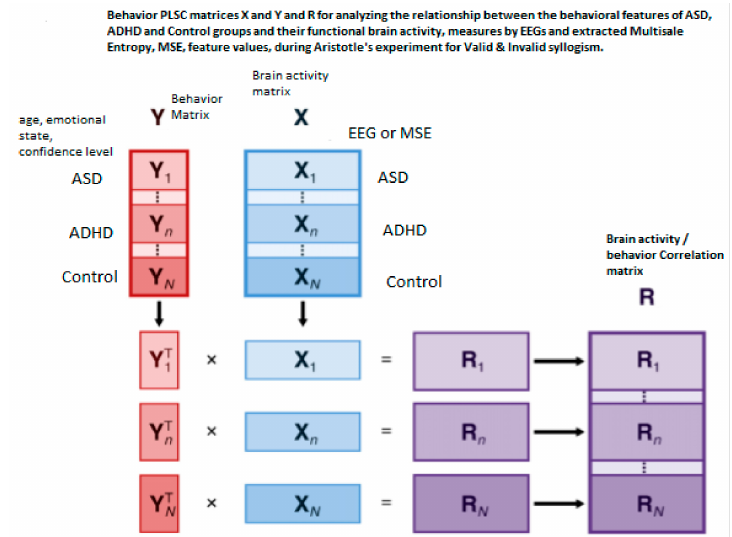
Figure 3. Construction of matrices X, Y, and extracted correlation matrix R. The observations (mean of EEG or MSE per subject) are arranged according to 3 conditions (ASD, ADHD, and control). X, Y are normalized within condition. The matrix of correlations R n between each condition-wised sub-matrix ( X n , Y n ) are stacked one below other to form the total-combined correlation matrix R, which finally is decomposed by singular value decomposition, SVD. X matrix has 21 rows (one per subject) for ASD, 21 for ADHD, and 21 for control, and 14 columns corresponding to channels. Y has 21 rows for ASD, 21 for ADHD and 21 for control, and 3 columns corresponding to 3 behavioral